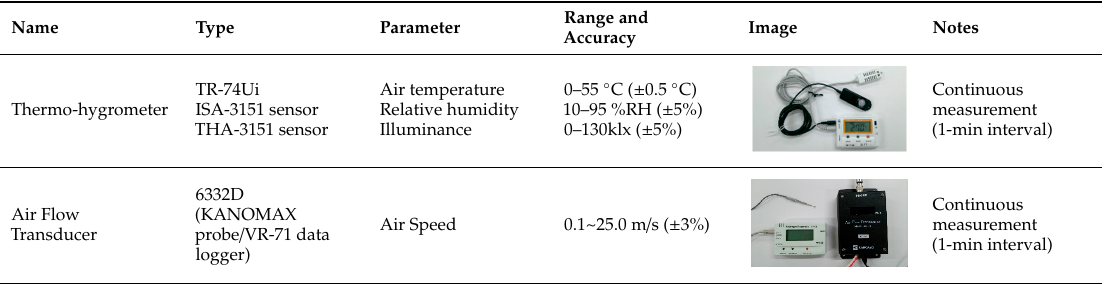
Table 1. Measuring